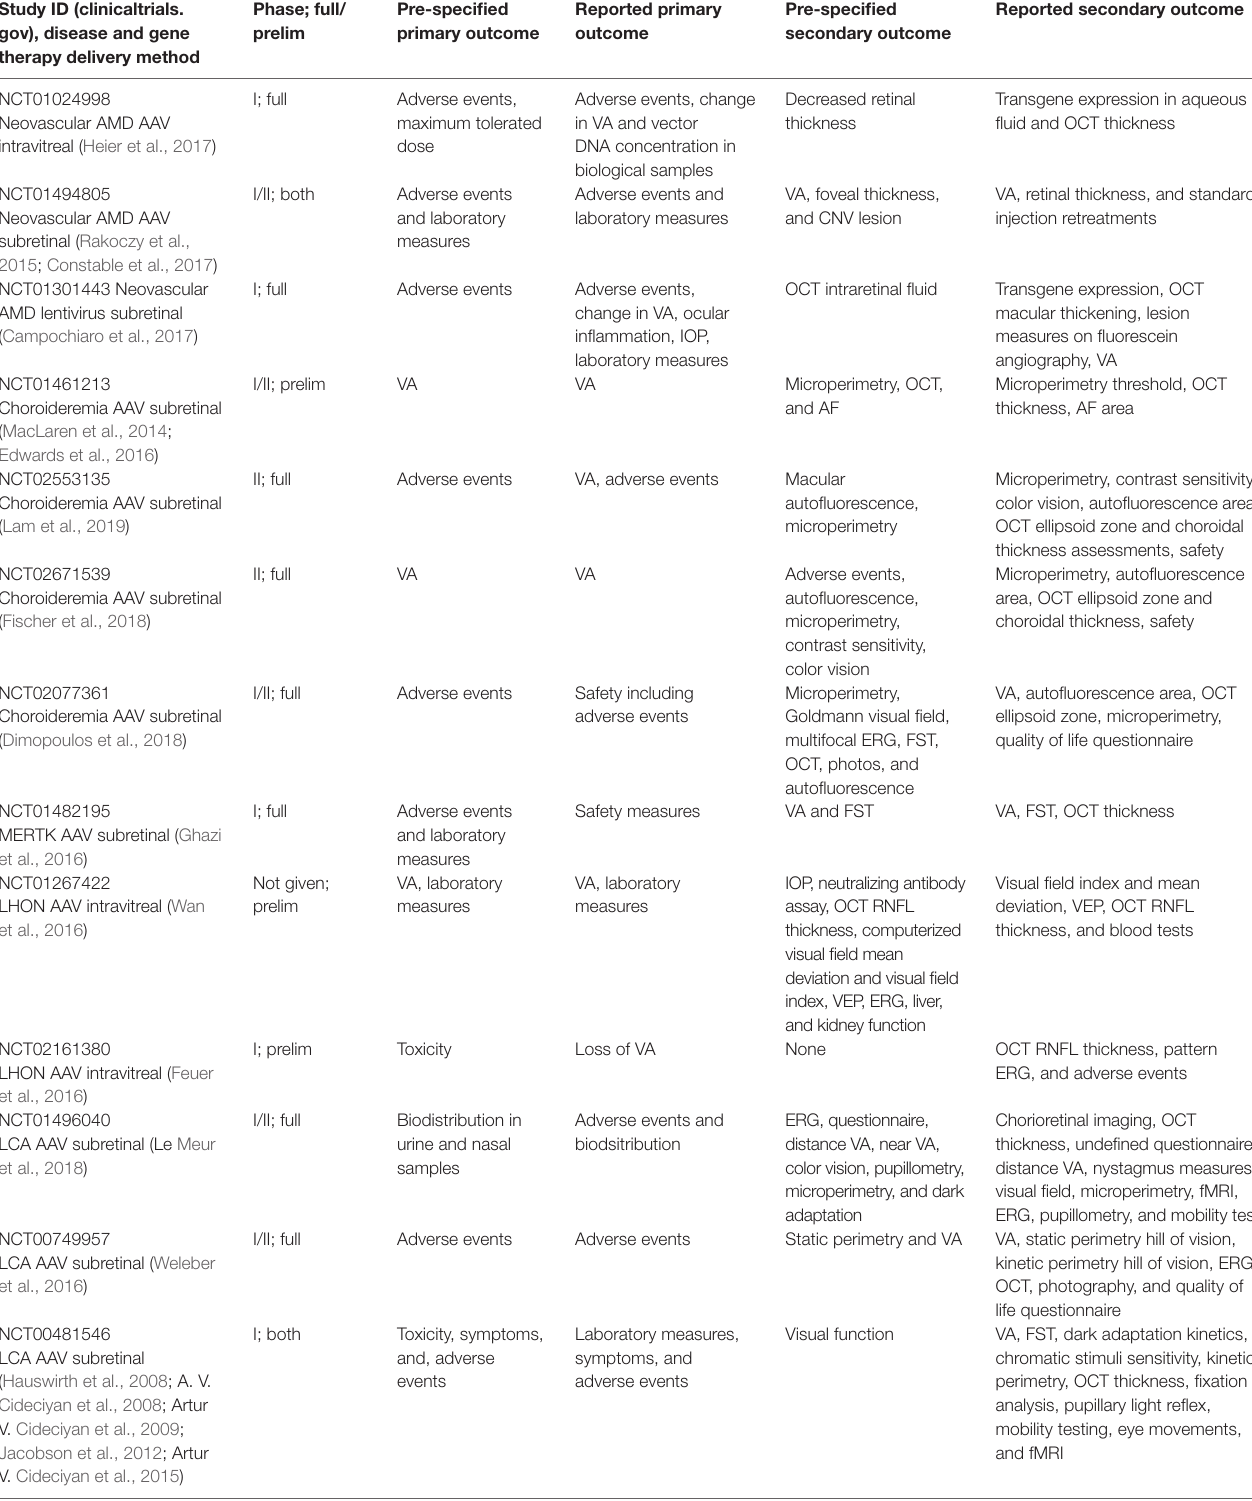
TABLE 1 | Comparison of clinical trial record and published outcomes in ocular gene therapy trials. Study ID (clinicaltrials. gov), disease and